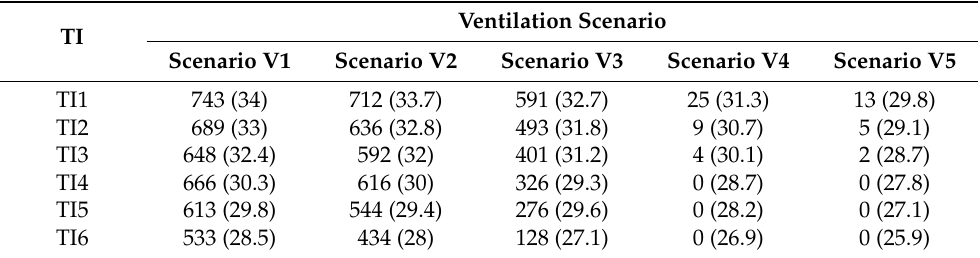
Table 5. Number of overheating hours for each scenario and, in brackets, maximum operative temperature in degree Celsius. Note that the overheating hours are calculated on the whole year and not only on the occupied